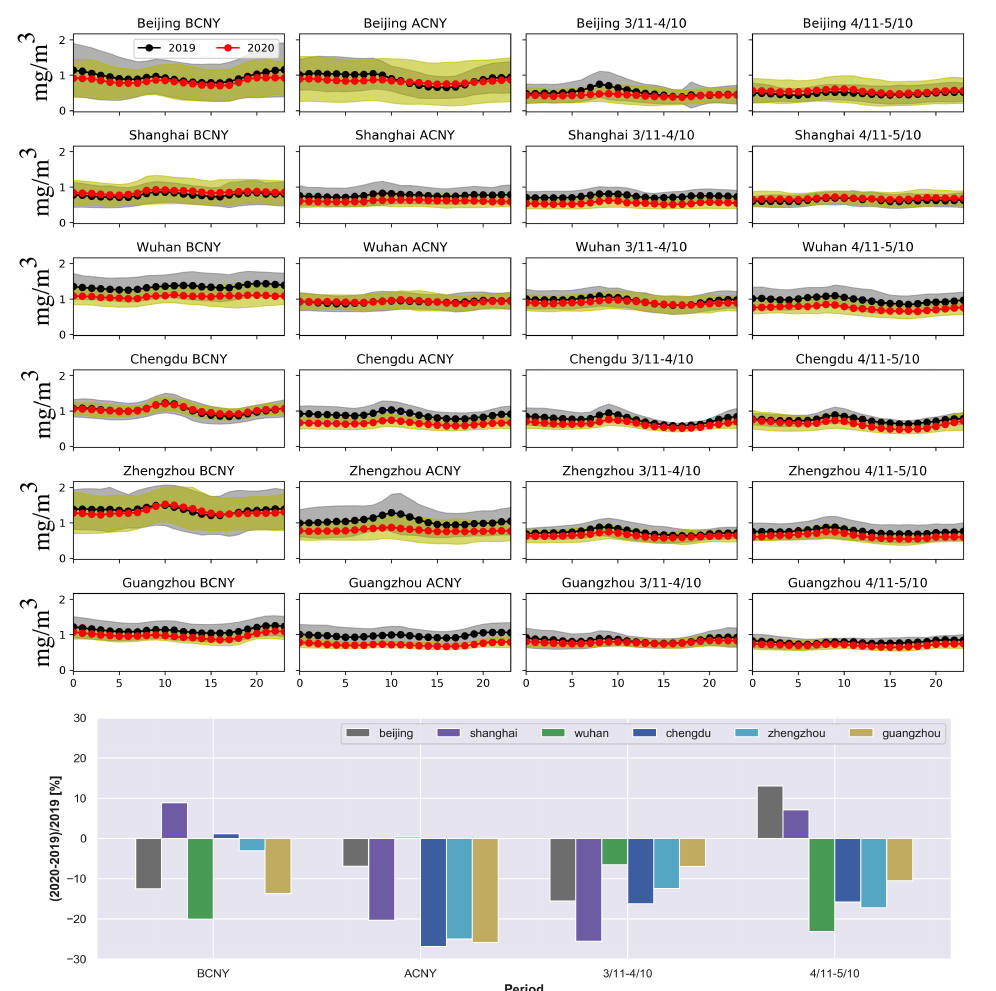
Figure 4. Upper: the hourly means (solid line) and standard deviations (shadow) of CO surface concentrations observed in Beijing, Shanghai, Wuhan, Chengdu, Zhengzhou, and Guangzhou during BCNY ( first column ), ACNY ( second column ), 3/11–4/10 ( third column ), and 4/11–5/10 ( last column ) in 2019 and 2020. Lower: the relative changes in CO surface concentrations between 2020 and 2019 in these six megacities during BCNY, ACNY, 3/11–4/10, and